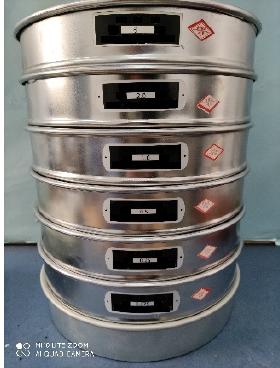
Figure 1. Standard soil sieve. After sieving, the soil particles were weighed in the different particle size ranges, and three replicate tests were carried out to analyze the test data, as shown in Table